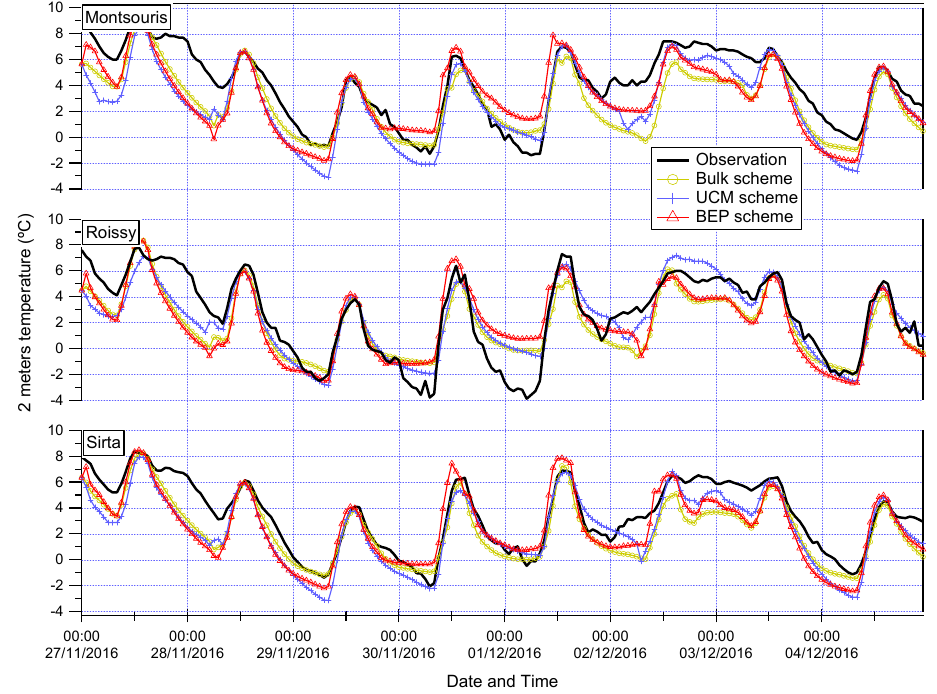
Figure 7. Time series of 2 m temperature (°C) between observations and different urban schemes at Montsouris, Roissy, and Sirta stations.